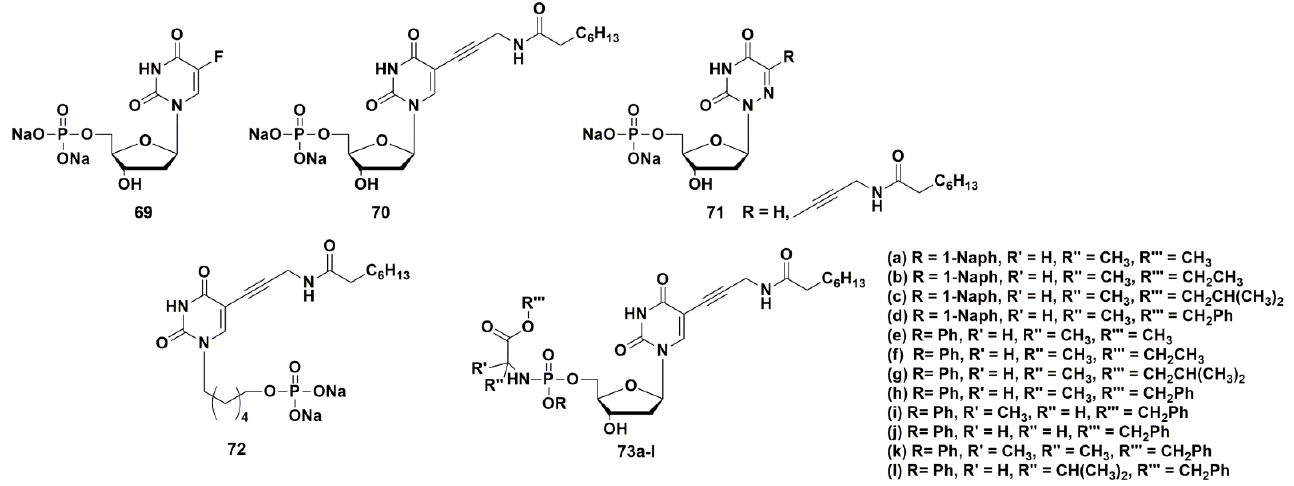
Figure 19. Structures of ThyX inhibitors.